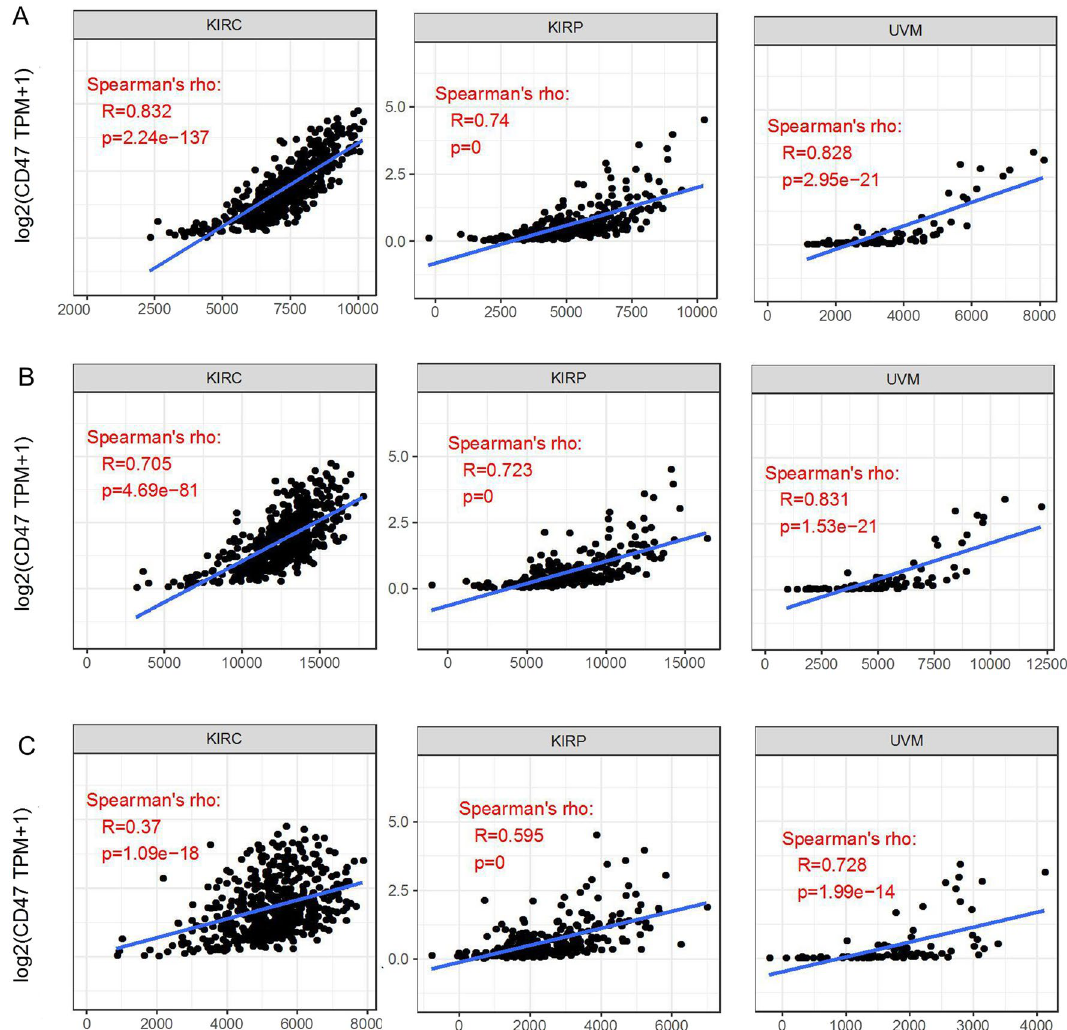
Figure 5. Correlation of TIGIT expression with Immune Score, Estimate Score and Stromal Score in KIRC, KIRP and UVM ( A – C